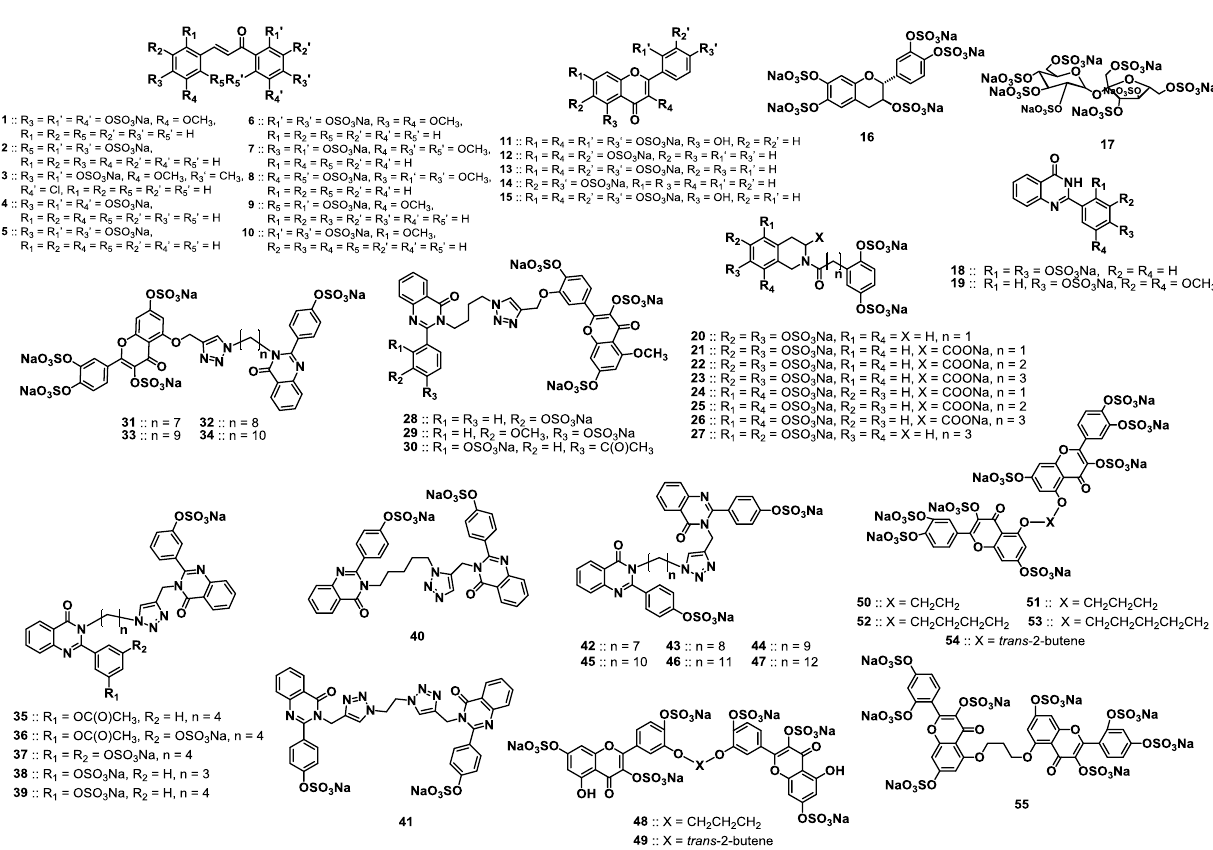
Figure 1. Structures of the sulfated small molecules screened for human plasmin